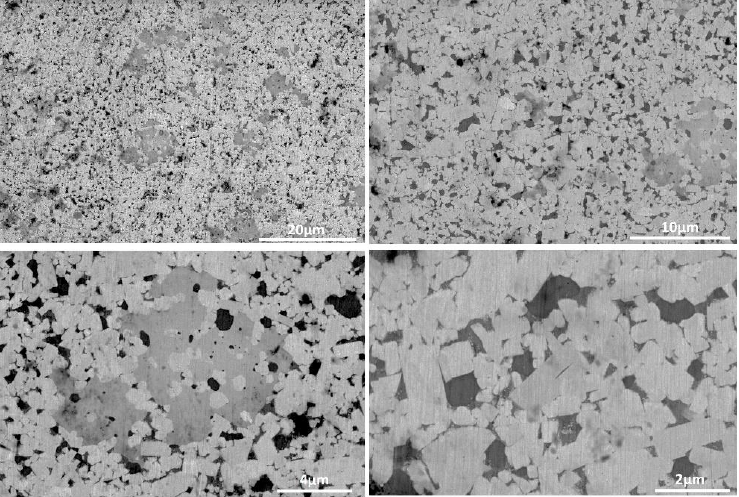
Figure 15. SEM micrographs of the consolidated WC-Co-TaC-NbC with 5 wt% Ni and 2.5 wt% Y 2 O 3 at different magnifications.